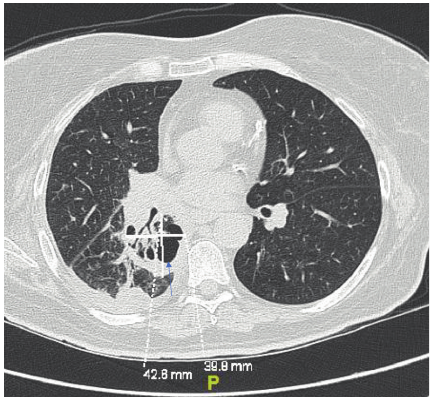
Figure 1: CT chest revealing the right upper lobe cavitary lesion (blue arrow).